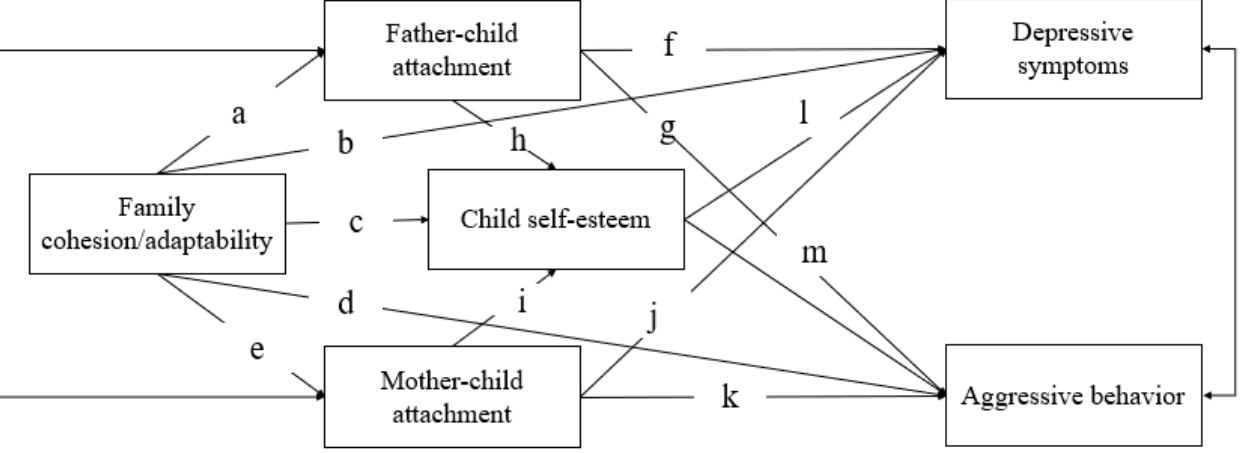
Figure 1. Proposed Model of Multilevel Family Factors and Emotional and Behavioral Problems of Children with ODD. Note. a—m indicates the effects of multilevel family factors on child depressive symptoms and aggressive behavior.